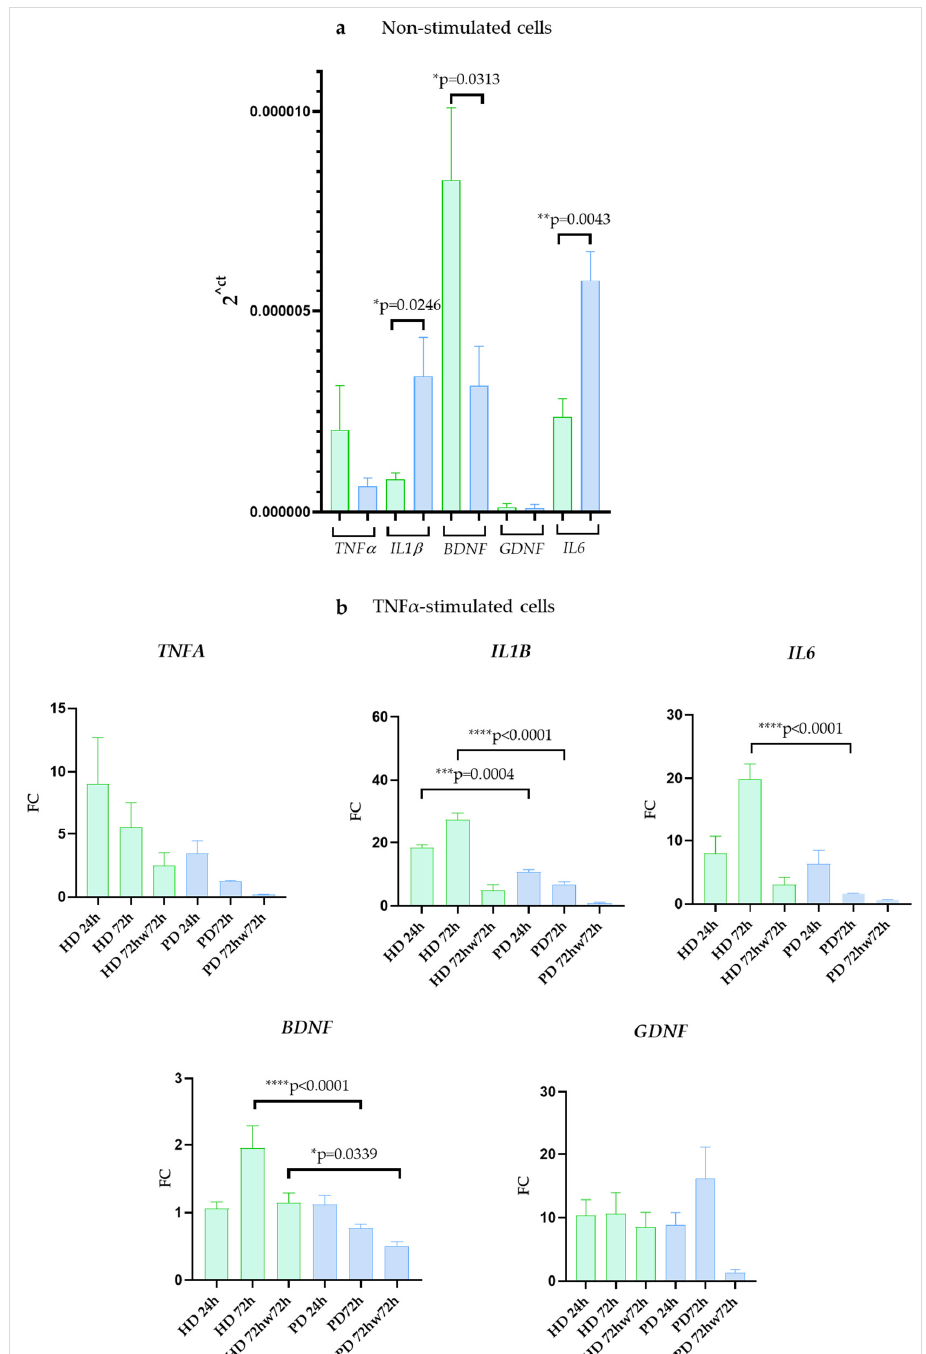
Figure 4. Gene expression in glial cultures derived from iPSCs of HD and patients with PARK2 - associated PD in steady state and under inflammatory conditions. ( a ), non-stimulated cells; ( b ), cells stimulated with TNFα. Green columns correspond to HD glial cultures, blue—to PD glial cultures. The gene expression was estimated using qPCR (n = 3). Fold change (FC) of expression was calculated relative to mean value in non-stimulated cells at each time point. The data are shown as mean ± SEM (n = 3). Unpaired two-tailed t-test (for non-stimulated cells) and two-way ANOVA with multiple comparisons corrected with Bonferroni test (for stimulated cells) were used for statistical processing. * p < 0.05, ** p < 0.005, *** p < 0.0005, **** p <